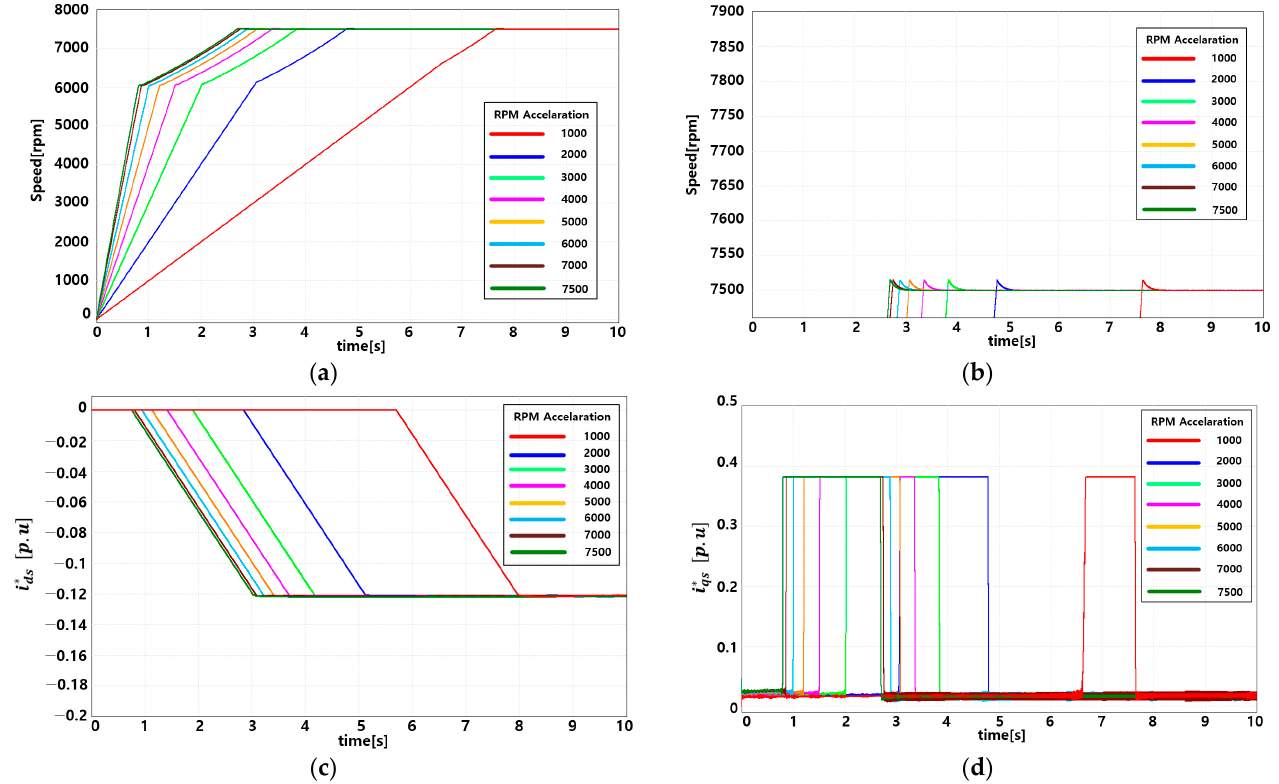
Figure 5. Simulation results when ∆ i ∗ is 5.34 × 10 − 5 : ( a ) motor speed; ( b ) motor speed; ( c ) d-axis current; ( d ) q-axis